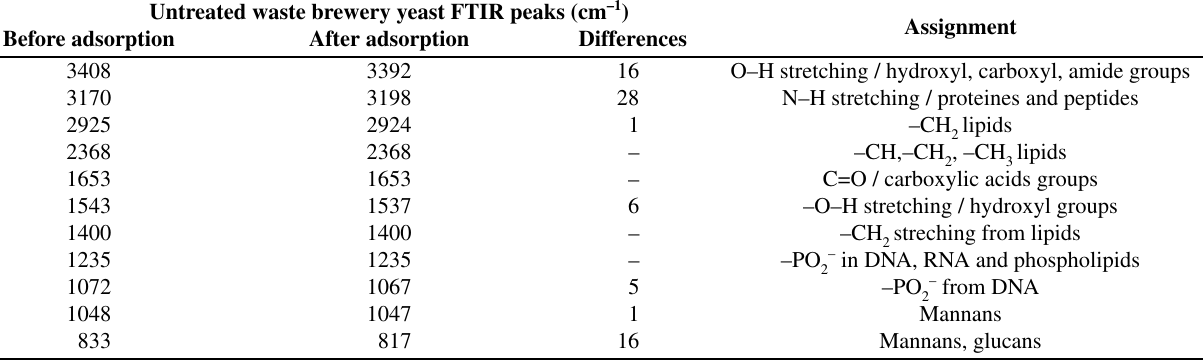
Untreated waste brewery yeast FTIR peaks (cm –1